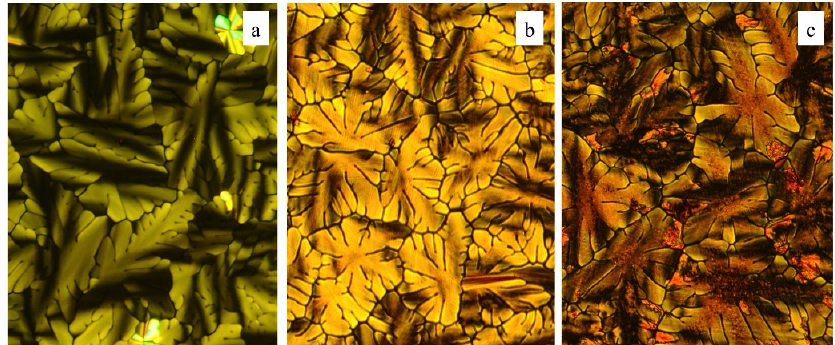
Figure 5. Polarized optical microscopy (POM) micrographs of compound 4 ( a ) at 175 °C; ( b ) at room temperature after 7 days and ( c ) at room temperature after 27